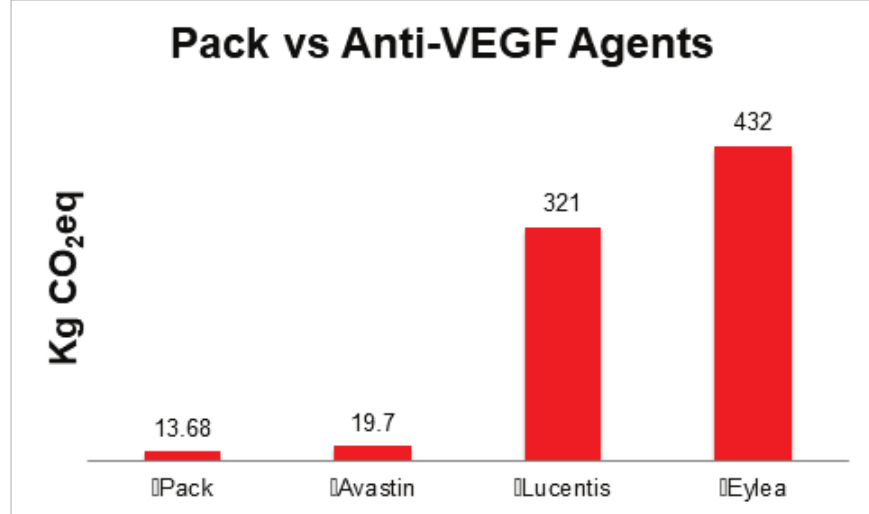
Figure 2. Estimated carbon emissions associated with the injection pack, Avastin, Lucentis, and Eylea. Kg CO2eq, kilograms of carbon dioxide